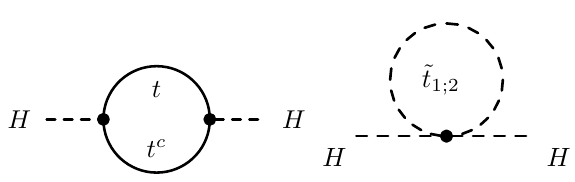
Figure 1 . Diagrams relevant to the cancellation of the top loop with spin-0 partners: the one-loop diagram for the SM top (left) and the two stops